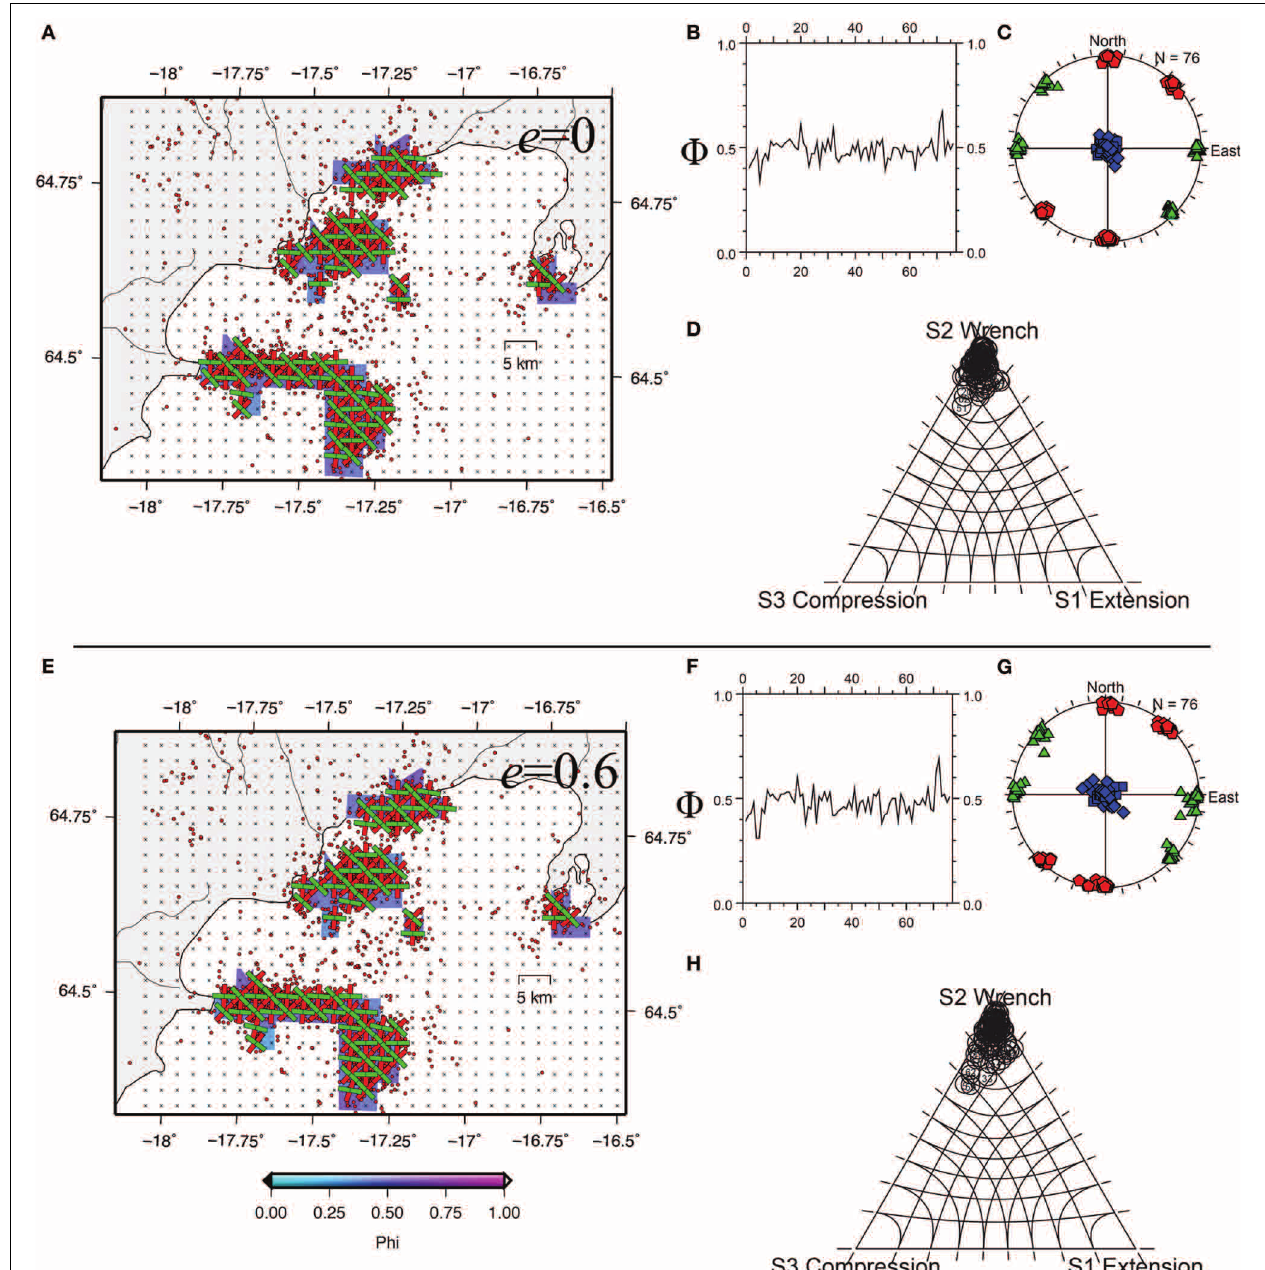
FIGURE 3 | Checkerboard tests using synthetic earthquakes based on the selected earthquake catalog. (A–D) With no damping ( e = 0): (A) map of the stress field issued from inversion of the synthetic earthquakes, superimposed red and green bars represent (cid:4) σ 1 and (cid:4) σ 3 respectively, denoting the strike slip regime; color bar denote the value of the stress shape ratio (cid:4) from the stress inversion; epicenters of earthquakes are represented as red dots; the small crosses show the